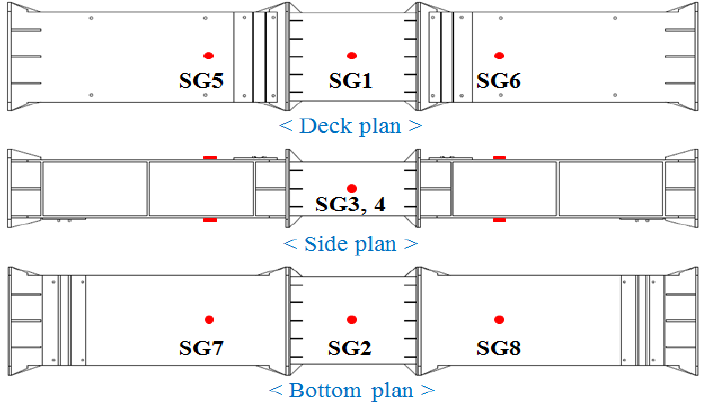
Figure 12. The strain gauge arrangement.